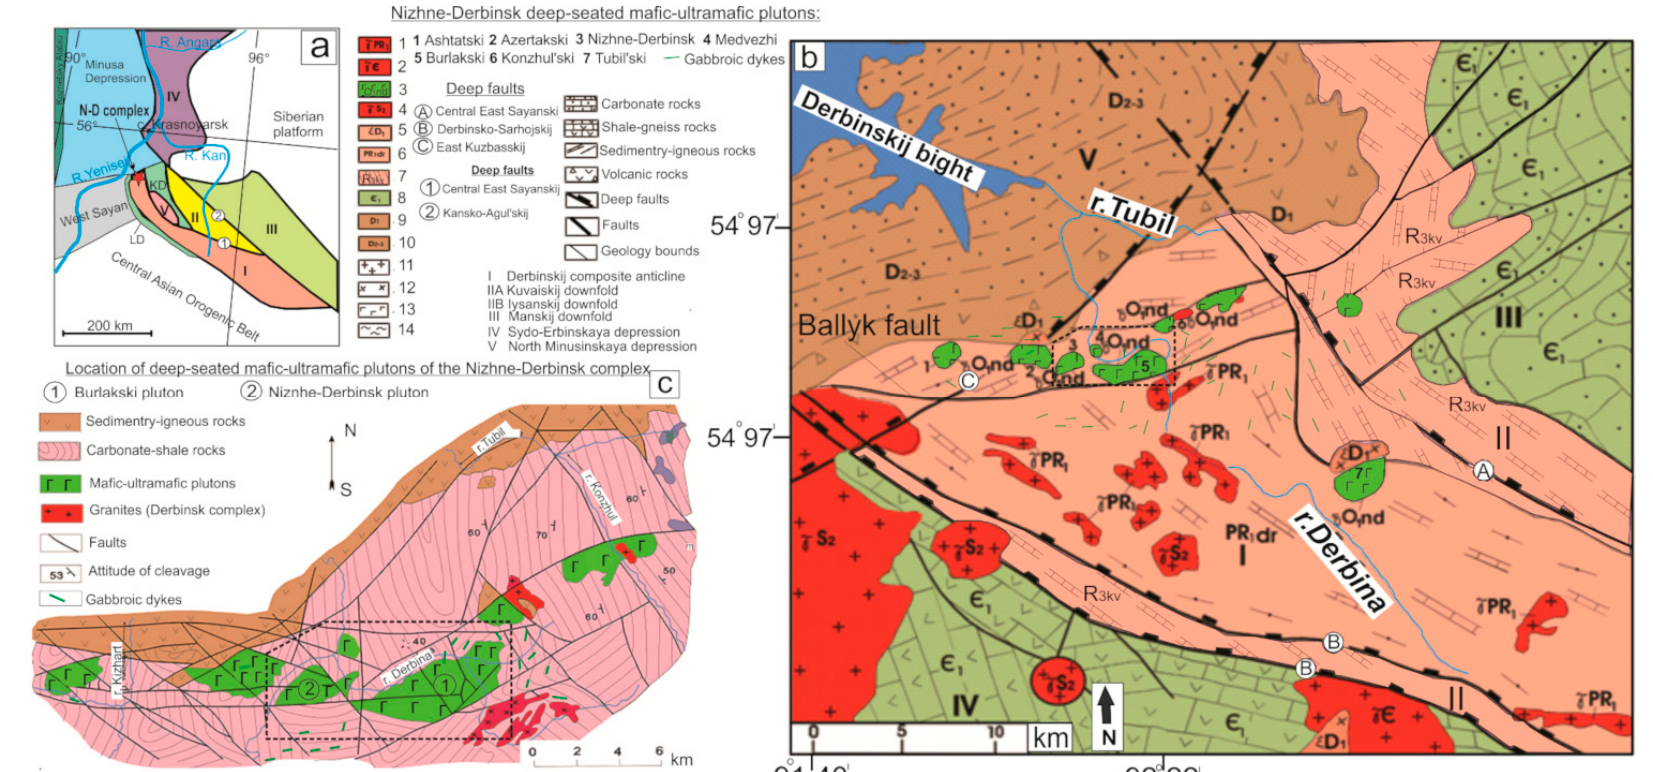
Figure 2. ( a ) Location of the Nizhne-Derbinsk mafic-ultramafic complex. I Derbinsky composite anticline, II Kansky block; crystalline basement protrusions of the Siberian platform: III Prisaynsky, IV Angaro-Kansky, V Azirbeysky; KD Kuvajskij downfold, LD Lysanskij downfold. ( b ) Simplified geologic map of the Derbinsk area (East-Sayan seriya) based on the 1:200,000 regional geologic map after [53]. 1 Derbinsk granitoid complex, 2 Ballyk granitoid complex, 3 Nizhne-Derbinsk mafic-ultramafic complex, 4 Shumichinsky granitoid complex, 5 Buejulsky syenitic complex, 6 Derbinsk metamorphic Formation, 7 Kuvay metamorphic Suite, 8 Sedimentary rocks, 9 Sedimentary rocks, 10 Sedimentary rocks, 11 Granites, 12 Syenites, 13 Gabbro, 14 Spilit-diabasic Formation. ( c ) Location of the deep-seated mafic-ultramafic plutons of the Nizhne-Derbinsk complex (modified after [49]).